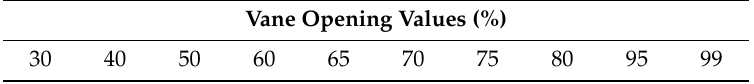
Table A3. Vane opening value series of cam relationship.